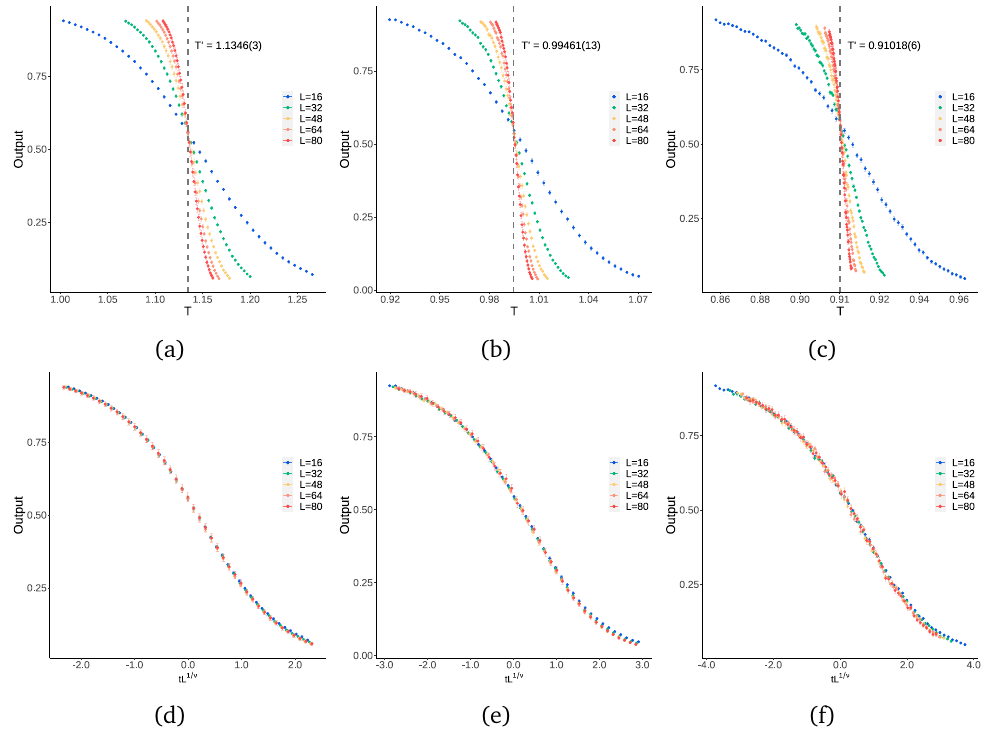
Figure 1: Generalization of Ising model-trained ANNs to the Potts model. a–c , Average q / 2-normalized outputs of Ising model-trained ANNs versus sampling tem- perature for spin configurations of the Potts models with q = 2 ( a ), q = 3 ( b ) and q = 4 ( c ). d–f , Finite-size scaled results of a–c . The error bars shown are 99.7% confidence